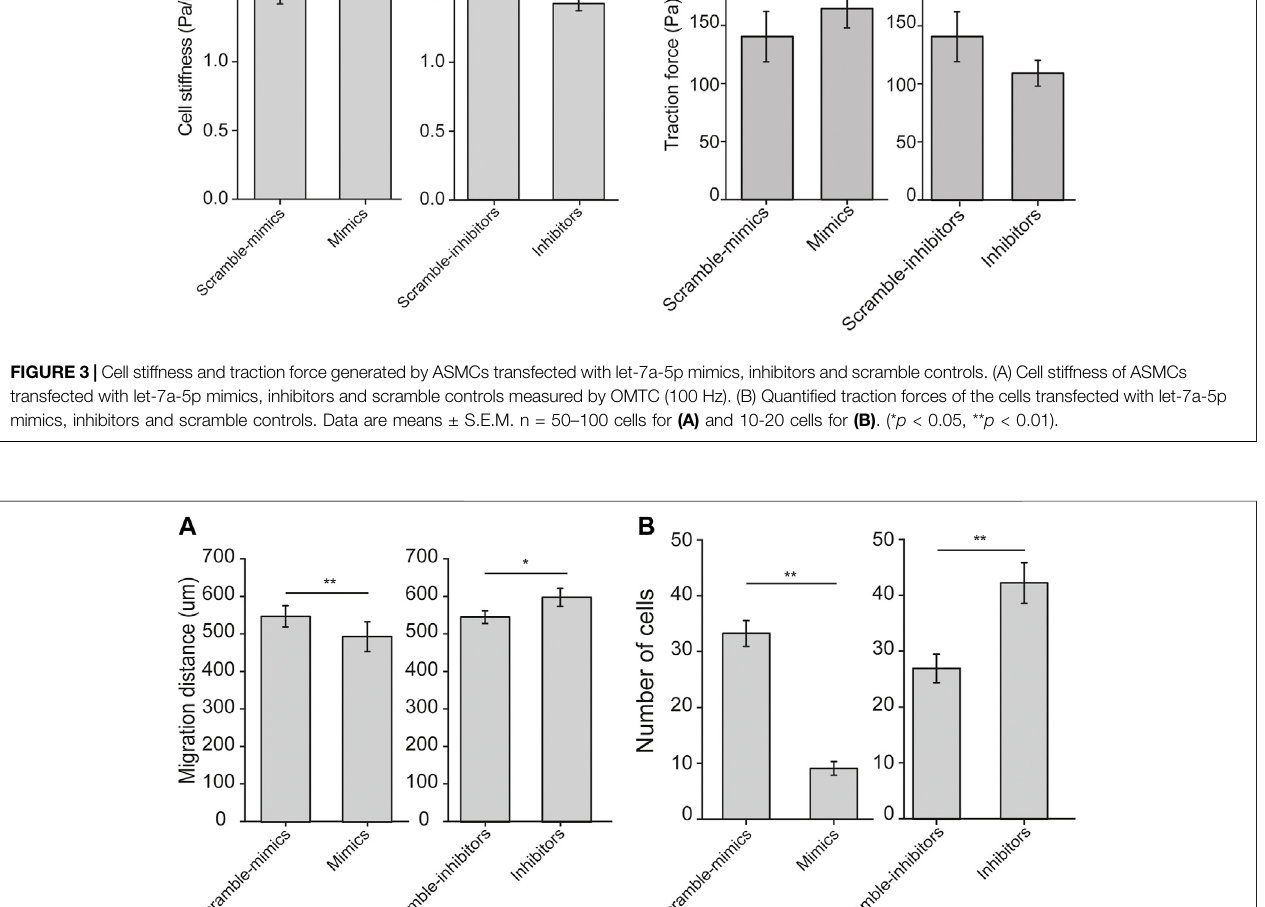
Frontiers in Physiology |